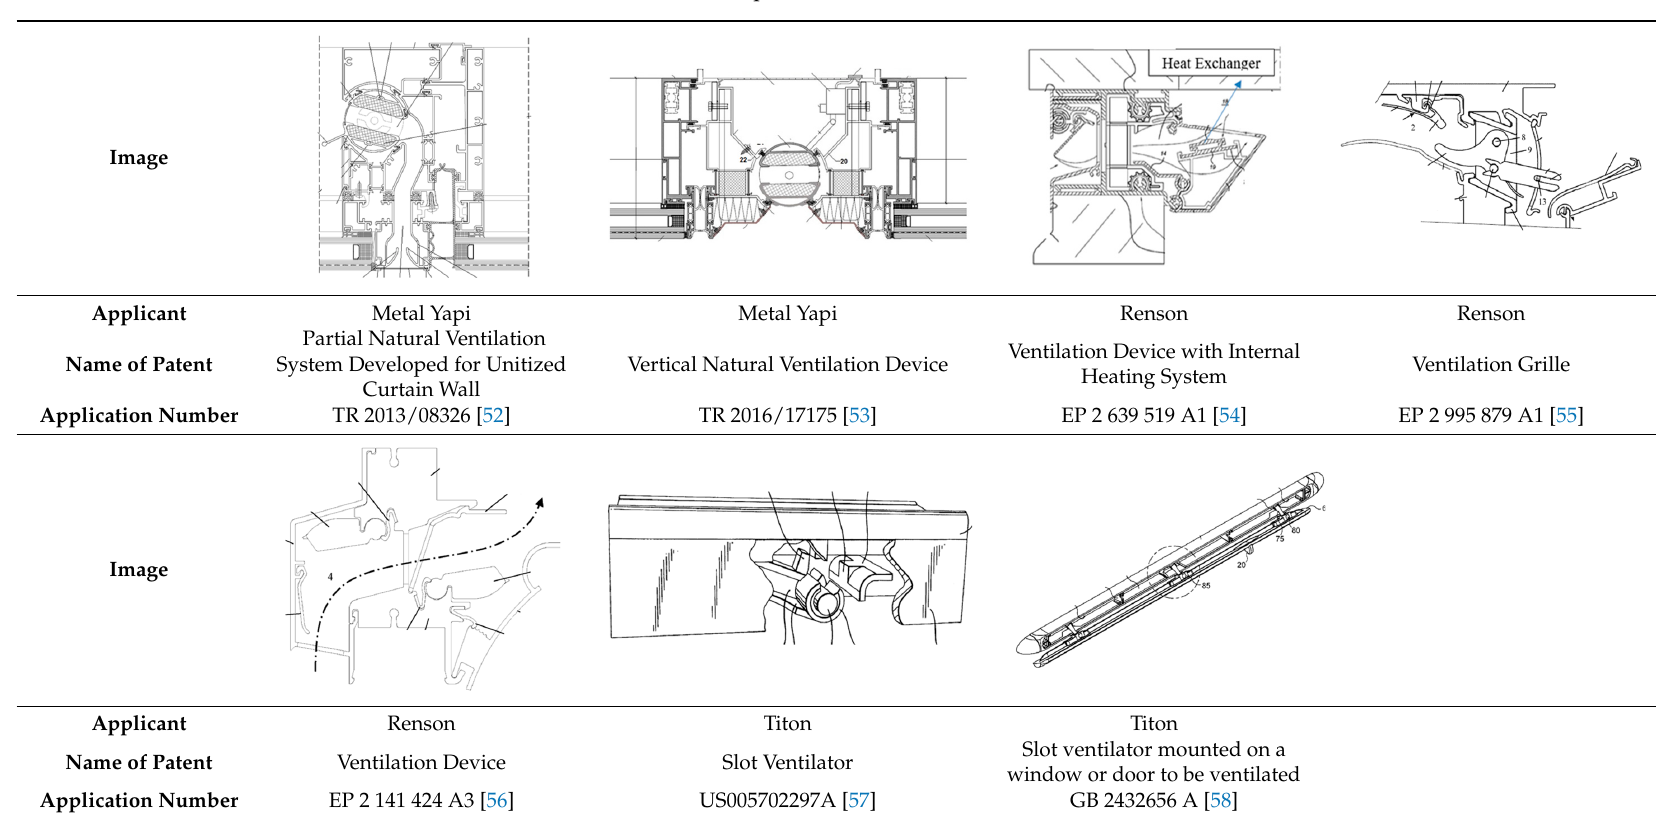
Table 2. Some of the patented vents available in the market.